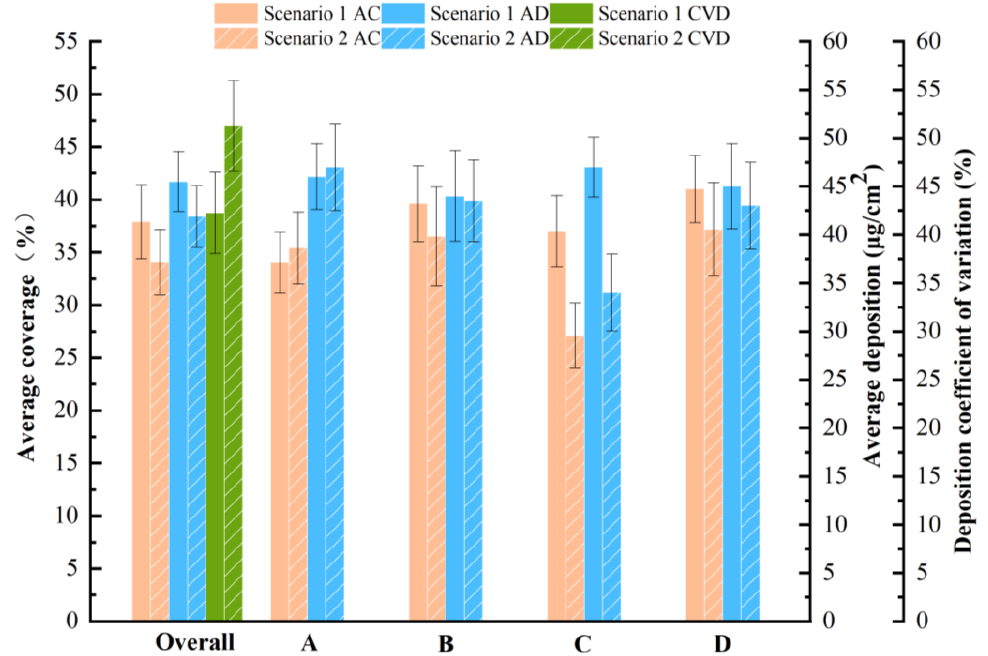
Figure 9. Comparative analysis of the effects of the two application scenarios. Table 3. Droplet drift under two application scenarios.